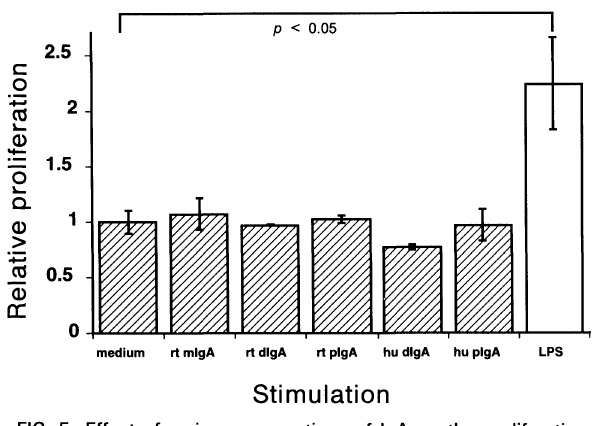
FIG. 5. Effect of various preparations of IgA on the proliferation of MC in vitro. MC were incubated with 10 lg/ml of various IgA preparations and LPS, as a positive control. The relative prolifera- tion is defined as the mean number of cells per well incubated for 7 days with IgA or LPS, divided by the mean number of cells per well incubated for 7 days with medium alone. Results are expressed as the mean -i- SoE.M. of triplicate